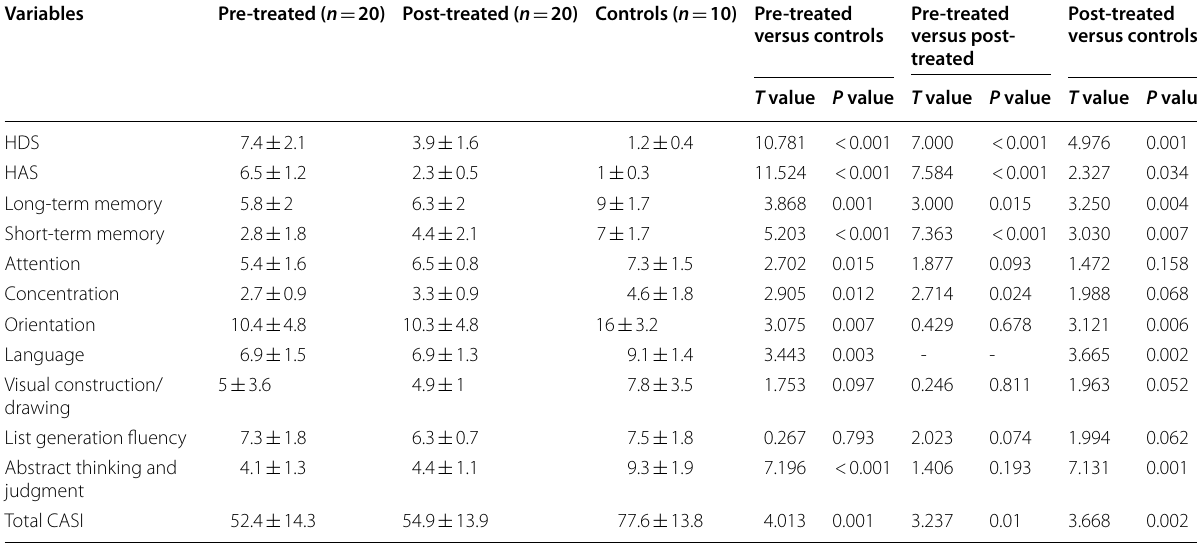
Values are presented as mean standard deviation or n (%). T -value for Student’s t -test. P -value < 0.05 is significant ± CASI: Cognitive Abilities Screening Instruments, HAS: Hamilton Anxiety Score, HDS: Hamilton Depression Score